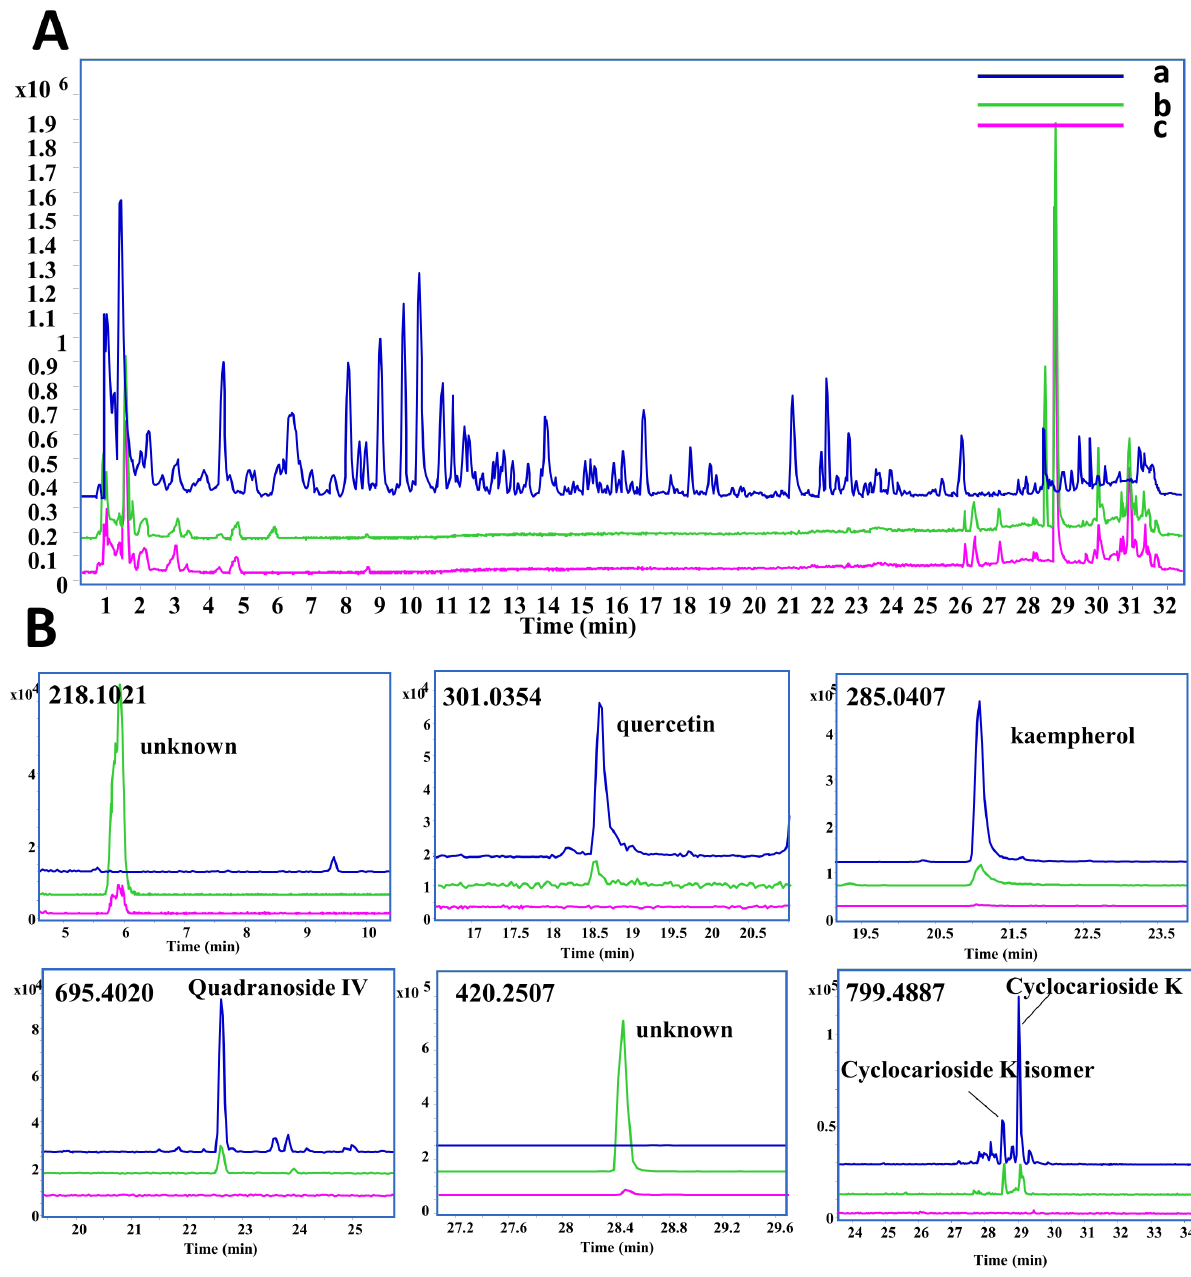
Figure 2: The total ion chromatograms of the chemical constituents in desorption eluate of pancreatic β NIT-1 cells incubated with CP extract. Total ion chromatograms (TICs) in negative mode of CP extract (a, blue line), desorption eluate of pancreatic β NIT-1 cells incubated with CP extract for 24 h (b, green line), desorption eluate of pancreatic β NIT-1 cells incubated without CP extract for 24 h (c, purple line). (A) The overall profile of ion chromatograms; (B) Enlarged ion chromatograms of potential active absorbed